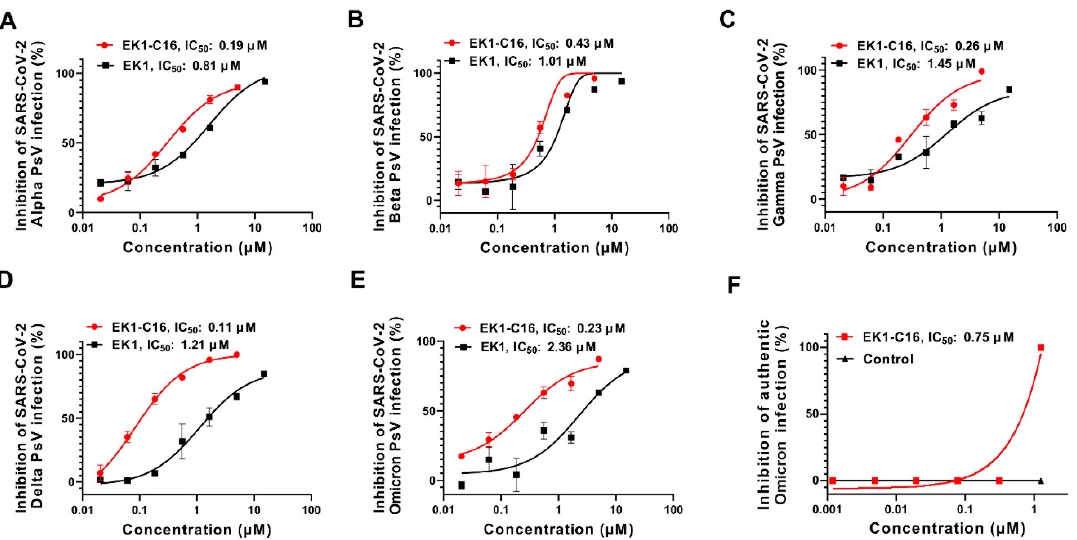
Figure 3. EK1-C16-mediated inhibition of infection by SARS-CoV-2 VOCs. EK1-C16-mediated inhibition of infection by pseudotyped SARS-CoV-2 Alpha ( A ), Beta ( B ), Gamma ( C ), Delta ( D ), and Omicron ( E ), and by authentic Omicron variant ( F ). The samples were tested in triplicate, and the experiment was repeated at least twice.